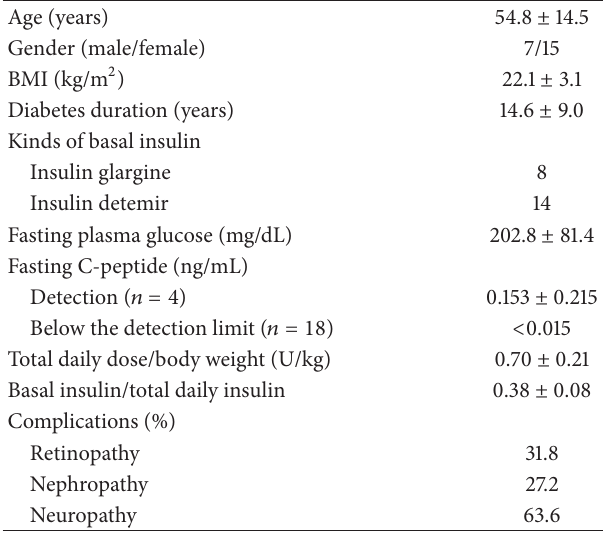
Table 1: Baseline characteristics of the